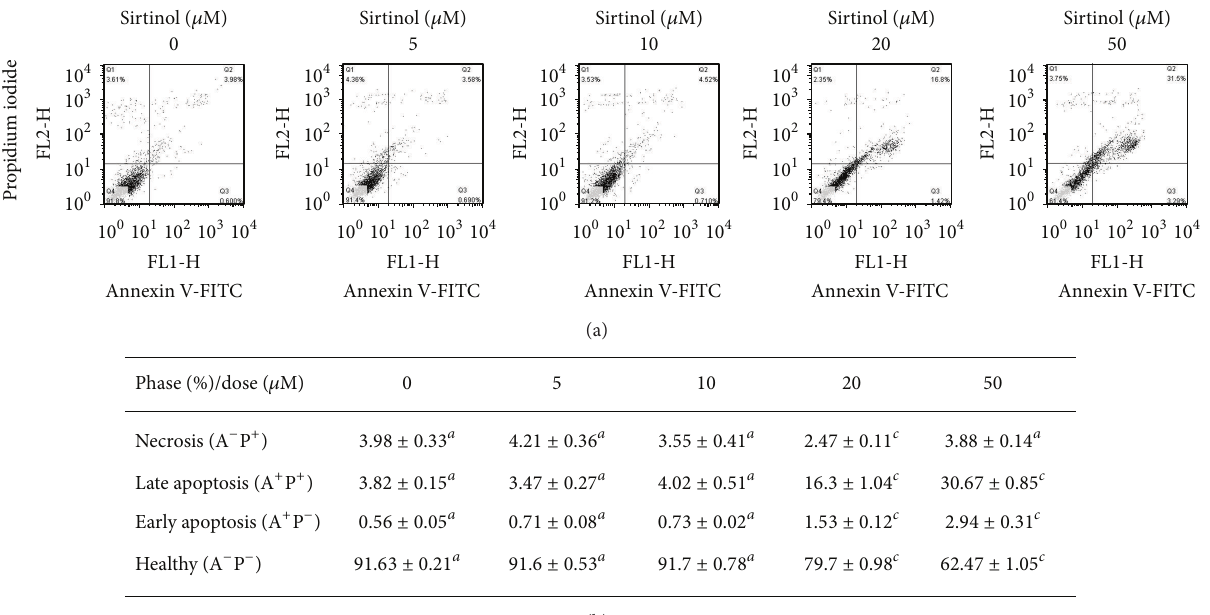
Figure 4: Sirtinol induces apoptosis of H1299 cells. Cells were treated with indicated concentrations of sirtinol and stained with Annexin-V and PI at 24 h, respectively. (a) Flow cytometry profiling represents the results of Annexin-V-FITC staining. (b) The quantificative analysis of cell apoptosis. Different letter notations indicate the statistical significance between sirtinol treatment and vehicle ( a versus b and a versus c indicate the 𝑃 < 0.05 and 0.001, resp.).